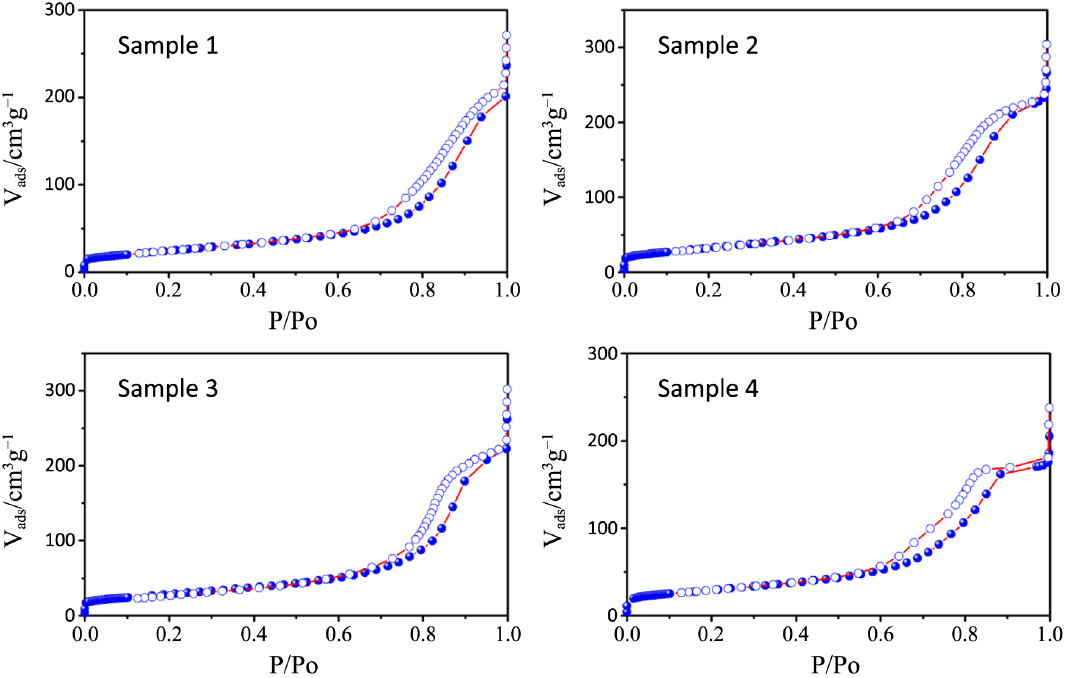
Figure 6. N 2 physisorption isotherms of samples